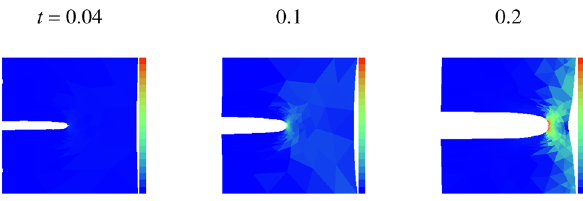
Fig. 23 Spatial profile of the phase field z (solid line) and density of hydrogen atom w (dotted line) at x 2 = 0 when D 0 = 1, D 1 = 100 (upper) and D 0 = 0.1, D 1 = 100